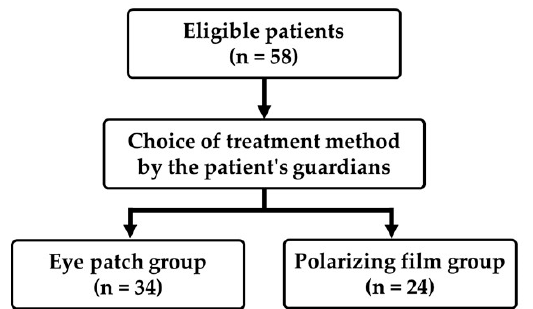
Figure 4. The flow diagram of this study. The treatment method was determined by the choice of the patient’s guardian.